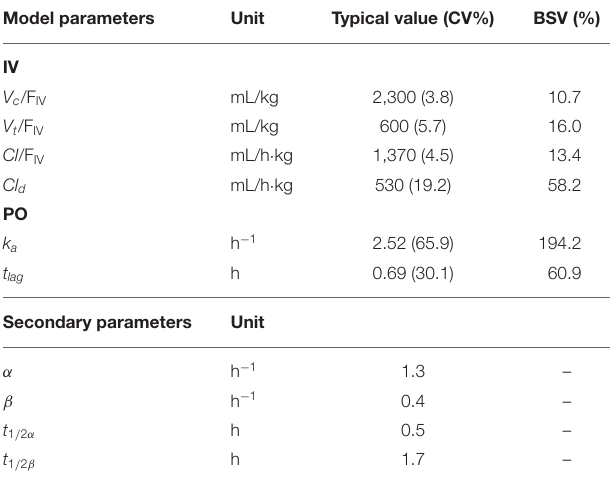
TABLE 2 | Model estimated pharmacokinetic typical values, their corresponding relative standard deviation (CV%) and the between subject variation (BSV) and secondary pharmacokinetic parameters after intravenous (IV) administration of 1 mg/kg prednisolone succinate and administration of ∼ 1 mg/kg prednisolone per os